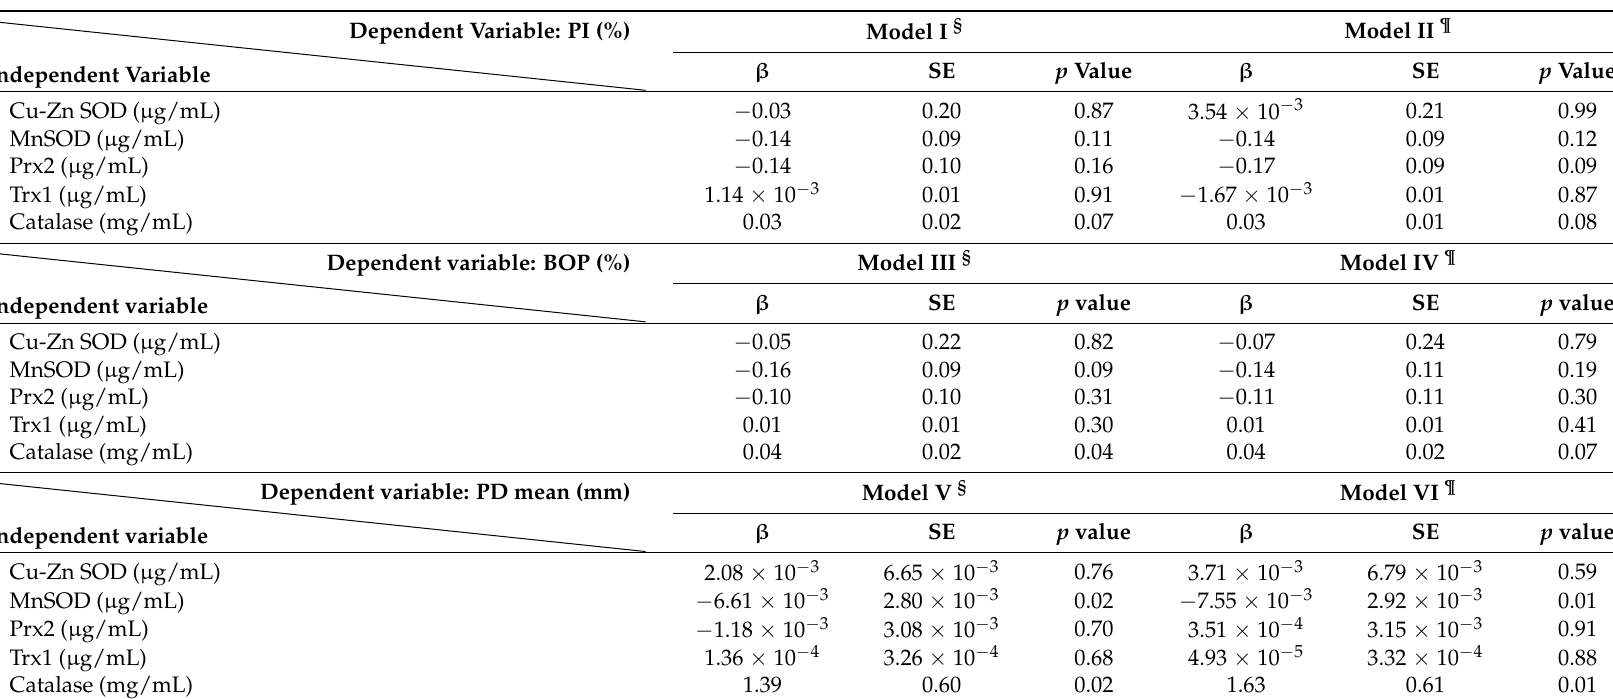
Table 5. Multiple regression analysis of salivary oxidative stress biomarkers and clinical periodontal parameters in subjects whose last previous dental visit was <1 year ( N =